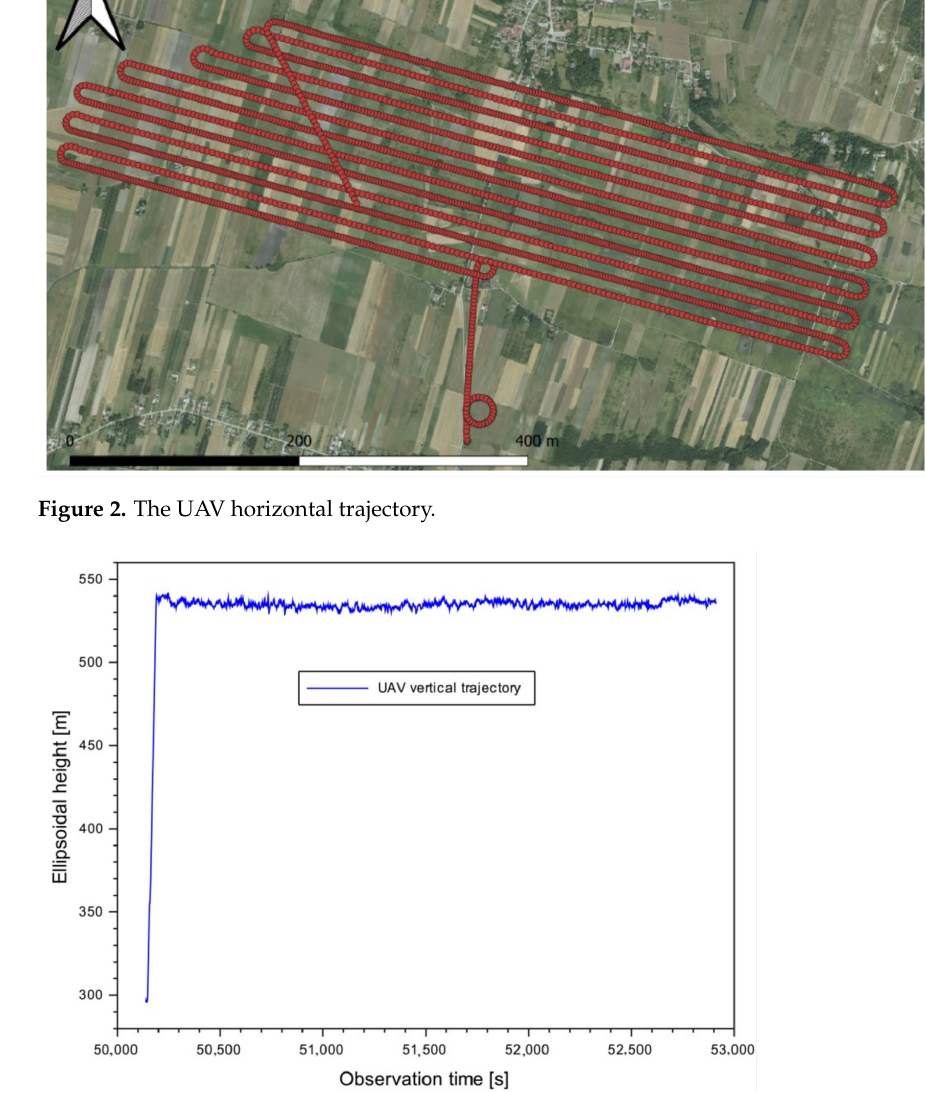
Figure 3. The UAV vertical